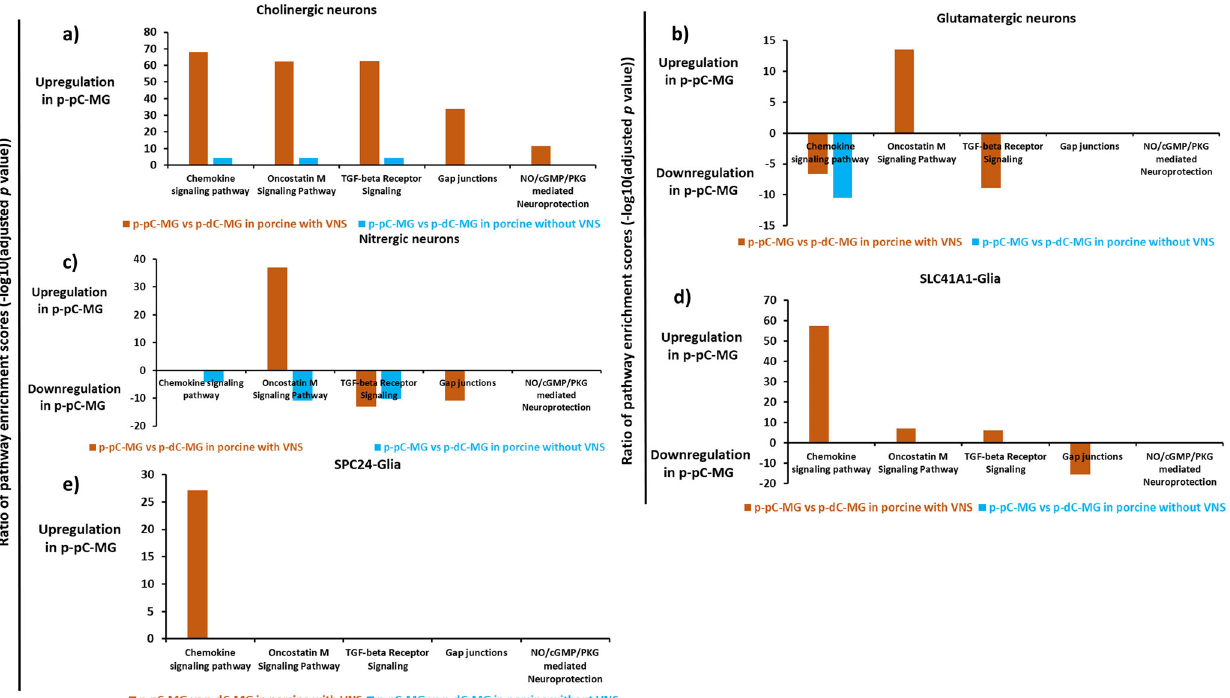
Fig. 8 Comparison of cell-type pathway enrichment in myenteric ganglia (MG) of porcine proximal and distal colon (p-pC, p-dC) with and without vagal nerve stimulation (VNS). The fi gures show the enrichment ratio of the same WikiPathway involving upregulated and downregulated genes in each list of differentially expressed genes and only show the enrichment ratio of the top fi ve WikiPathways in cholinergic neurons a , glutamatergic neurons b , nitrergic neurons c , SLC41A1-glia d , and SPC24- glia e . The light blue color represents the cell-type enrichment ratio without VNS and the orange color represents the cell-type enrichment ratio with VNS.